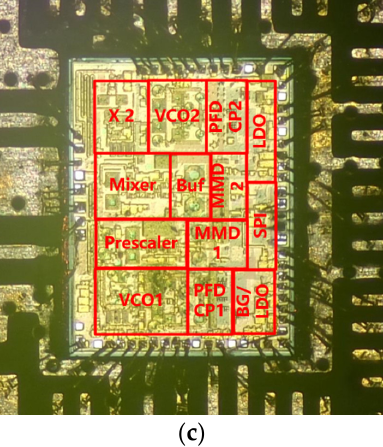
Figure 8. ( a ) Measurement setup environment for the output spectrum and phase noise of the dual- loop dual-output synthesizer chip; ( b ) photograph of the wire-bonded dual-loop dual-output fre- quency synthesizer chip; ( c ) function module blocks in the chip.